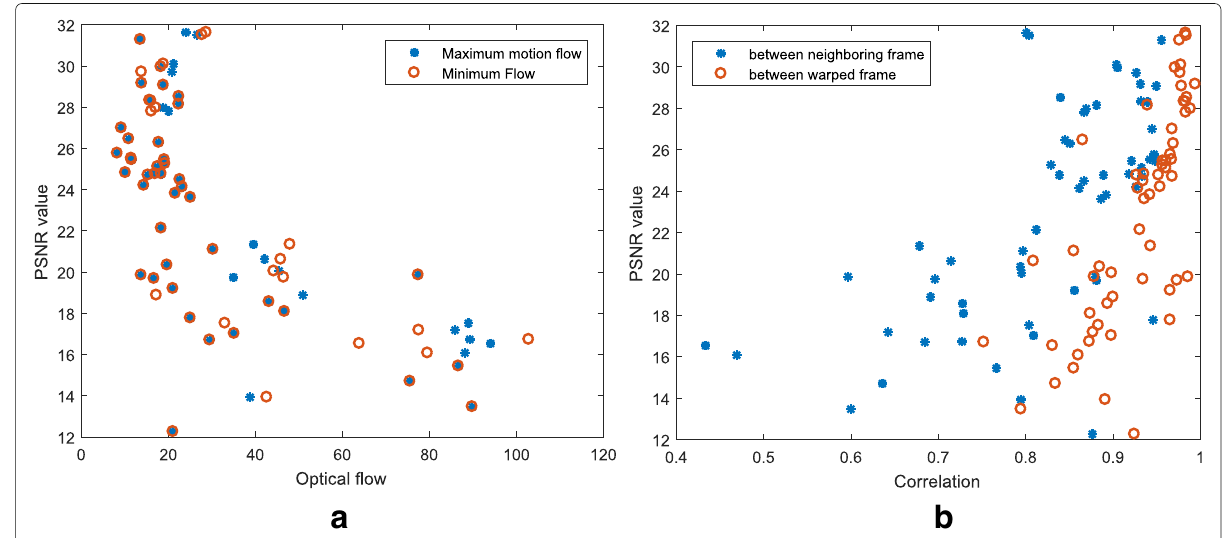
a b Fig. 8 Frame interpolation quality for all sequences. a PSNR value against maximum (star) and minimum (circle) optical flow magnitude of each frame and b the correlation between neighboring frames (star) and warped flow on I ( x , n − 1 ) and I ( x , n + 1 ) (circles)